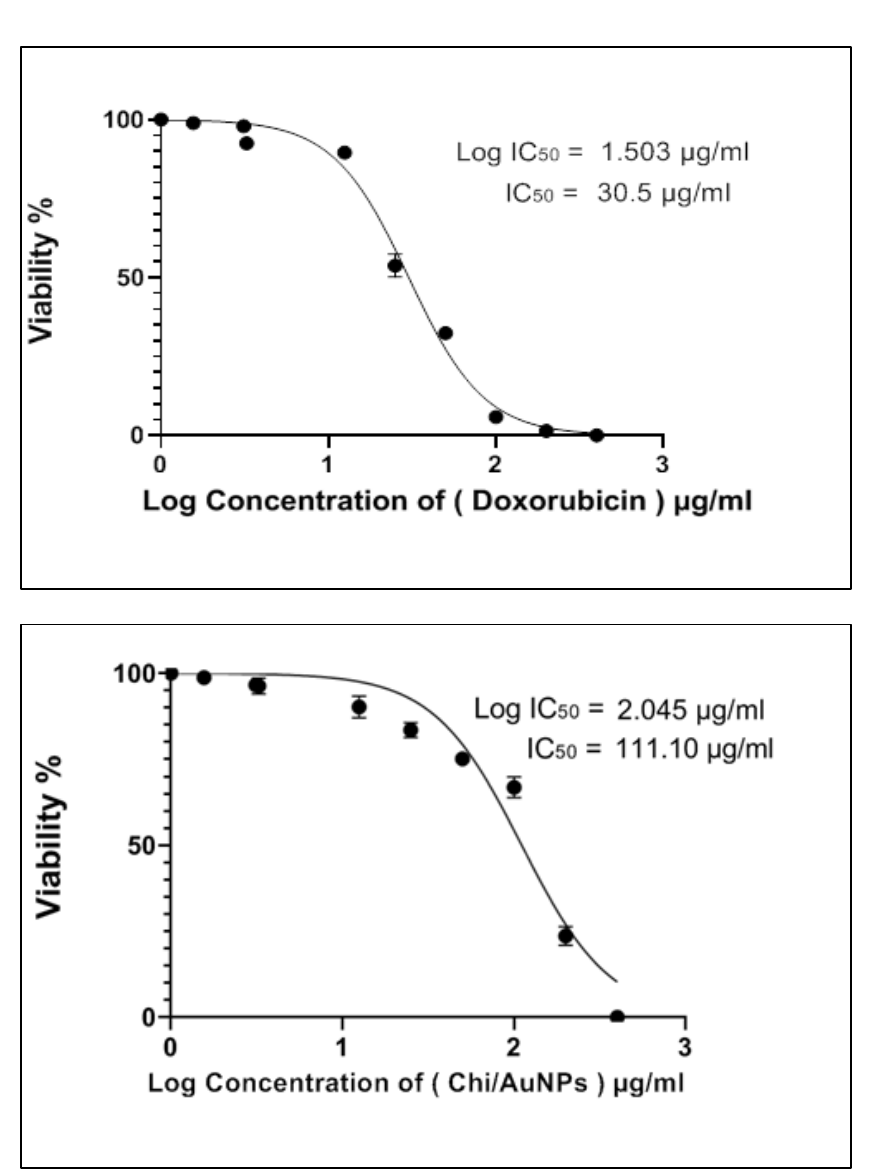
Figure 3. In vitro cytotoxicity effects on doxorubicin and Chi/AuNPs against the normal human skin cell line (BJ-1), assessed by SRB colorimetric assay, respectively.